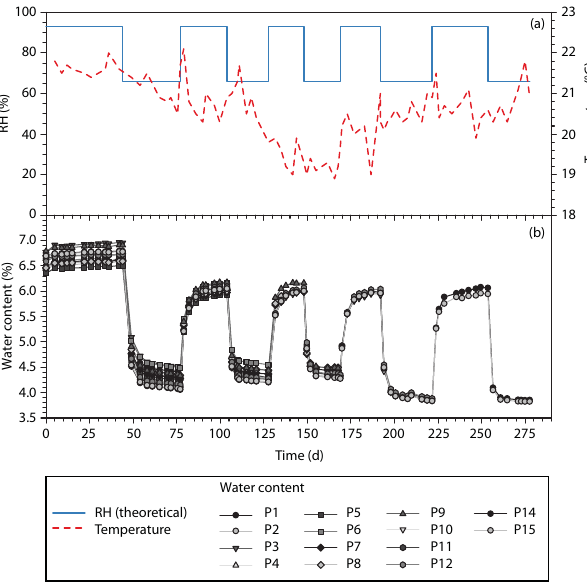
Figure 6. Results of the stepwise cyclic RH experiment for the P specimens, including (a) the theoretically applied levels of relative humidity (RH) and the measured temperature (in the laboratory) and (b) the water content of the